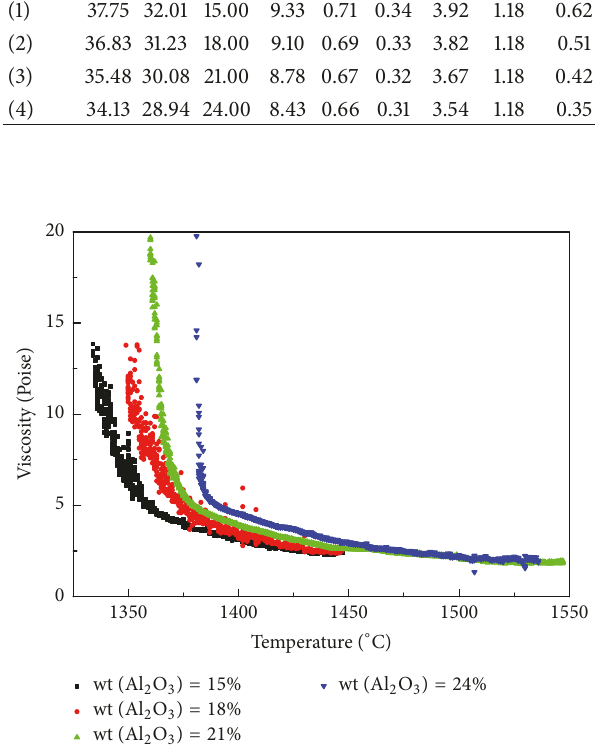
Figure 3: Effect of Al 2 O 3 content on viscosity-temperature